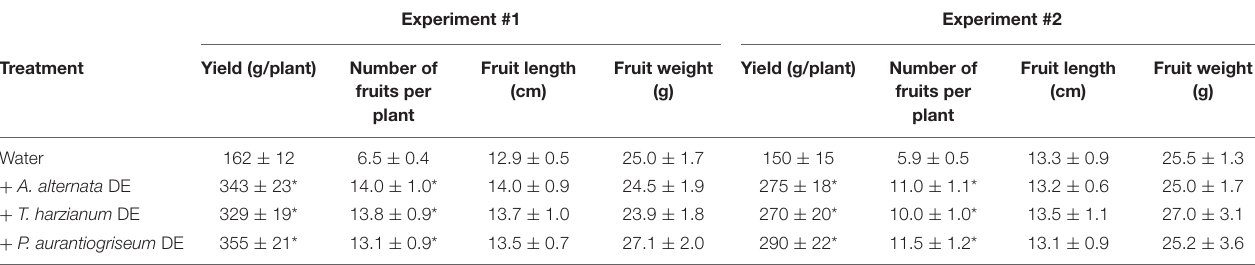
TABLE 6 | Soil application of DEs obtained from A. alternata, P. aurantiogriseum , and T. harzianum cultures enhances commercial fruit number and yield of pepper plants (cv. Sweet Italian) cultured under greenhouse conditions.